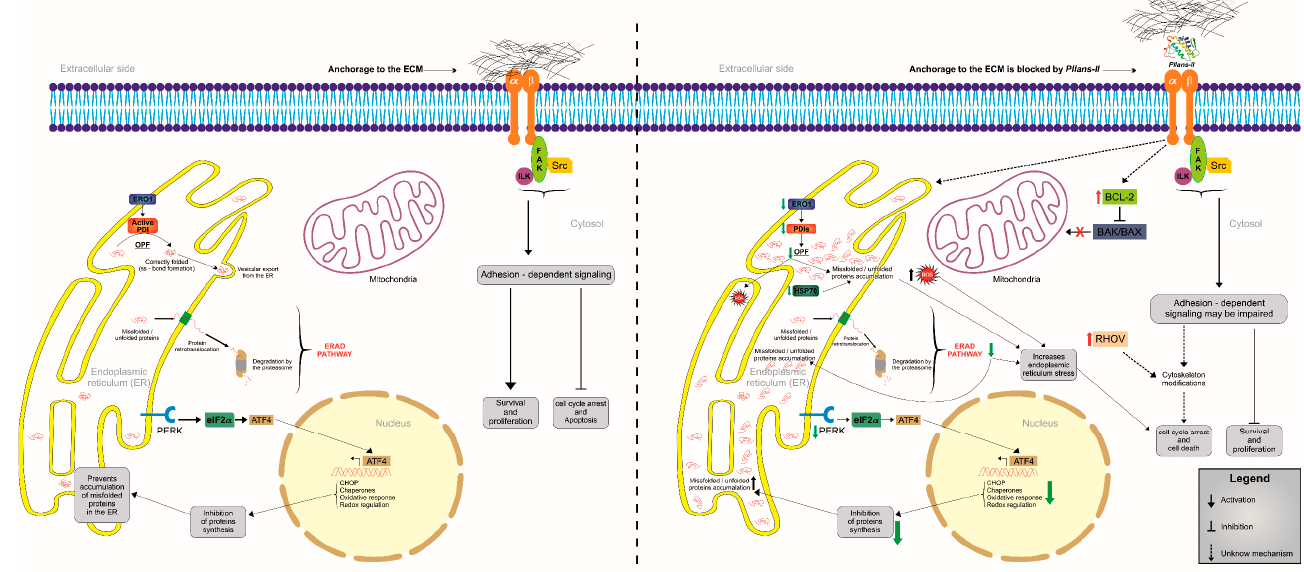
Figure 4. Representative model of antitumoral effects of Pllans–II on Ca Ski cells. The left part represents normal processes in untreated Ca Ski cells, where the ECM anchoring processes, the unfolded protein response (UPR), and the ER–associated protein degradation system (ERAD), develop in the endoplasmic reticulum, keeping the cells viable. The right part represents the possible effect of Pllans–II on cervical tumor cells. Pllans–II interferes initially with the binding of integrins to the ECM, which would affect cell adhesion and migration. In addition, this interaction could interfere with signaling pathways in the cell and modify the expression profile of genes related to UPR, mitochondrial permeabilization, and the ERAD pathway, which is usually responsible for the clearance of misfolded / unfolded proteins in ER. These effects would generate an increase in the stress on the endoplasmic reticulum in treated Ca Ski cells and not resolve it, leading to arrest in the cell cycle and apoptosis. Red arrows mean up–regulation, and green arrows mean down–regulation.